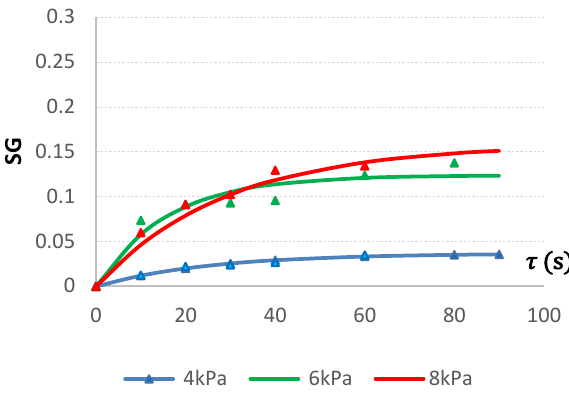
Figure 2. Changes of SG during impregnation of apples at varied vacuum pressures of 4, 6, and 8 kPa using apple-pear juice as the impregnating liquid.